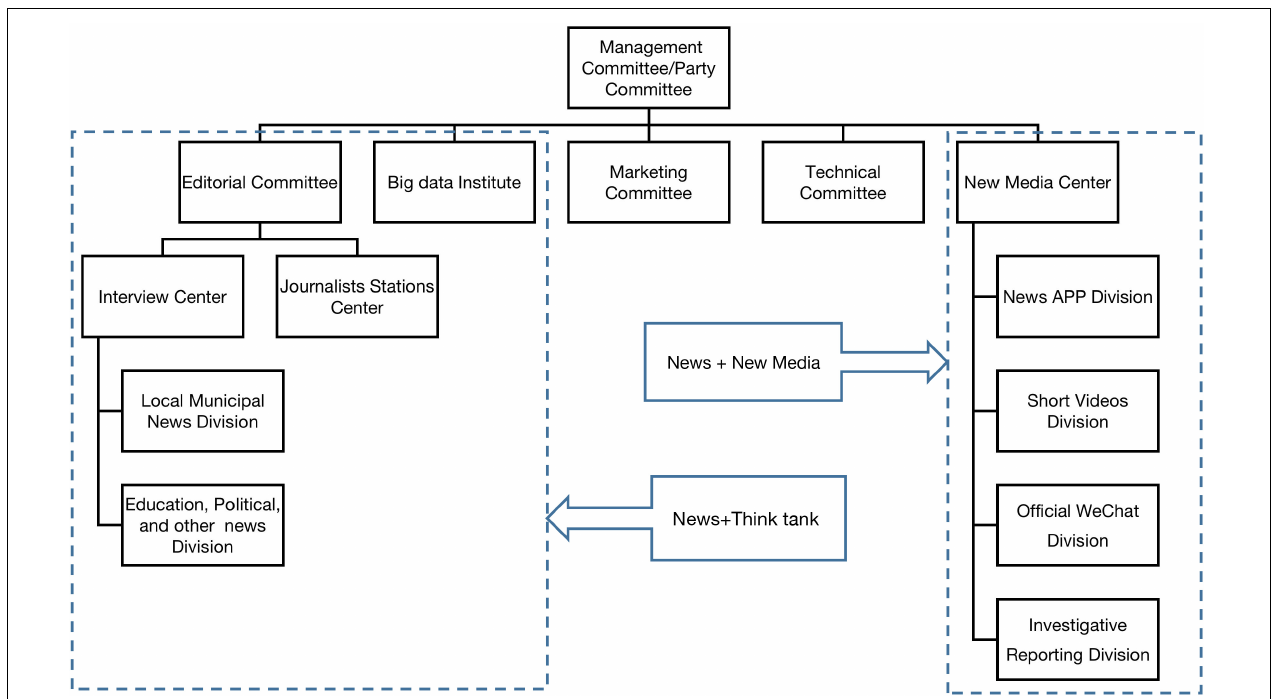
FIGURE 2 | The organizational structure of N in the stable